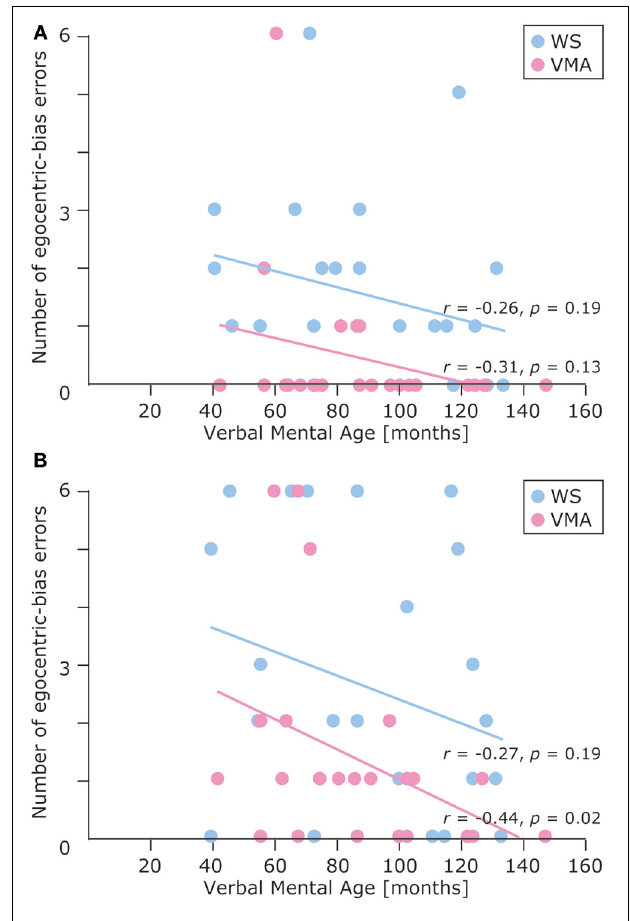
FIGURE 8 | Developmental trajectories for the number of correct responses in (A) the SM task, and (B) the SMI task for two groups [blue: Williams syndrome (WS) group; pink: verbal mental age-matched (VMA) group]. the SM task in the VMA group ( r = − 0 . 31, r = 0 . 13). We did not